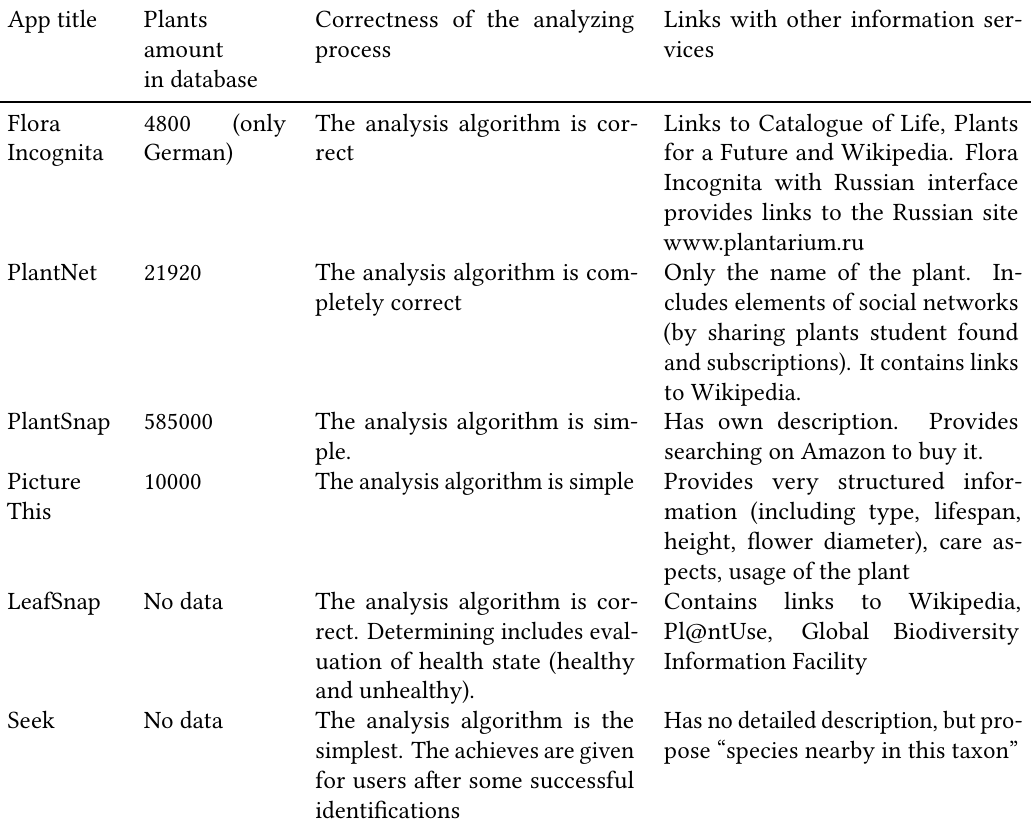
Comparison results of mobile applications that can analyze plant